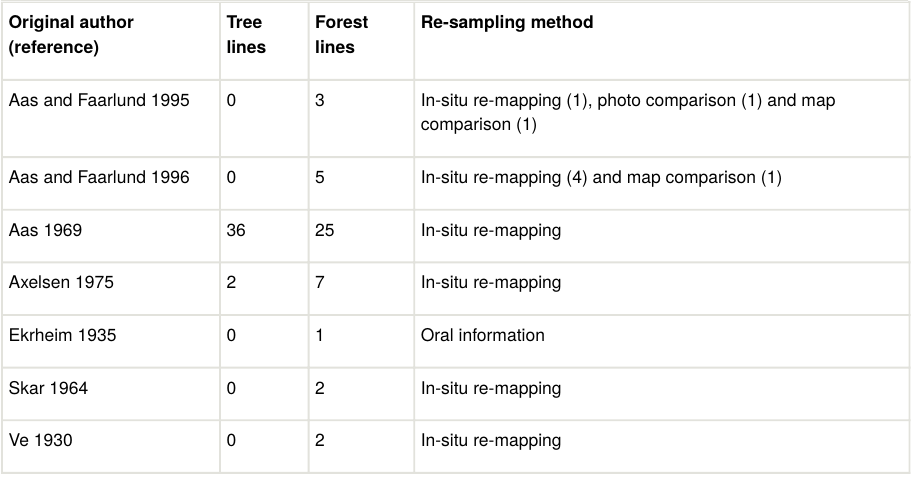
Reference to original author and number of entries of tree- and forest